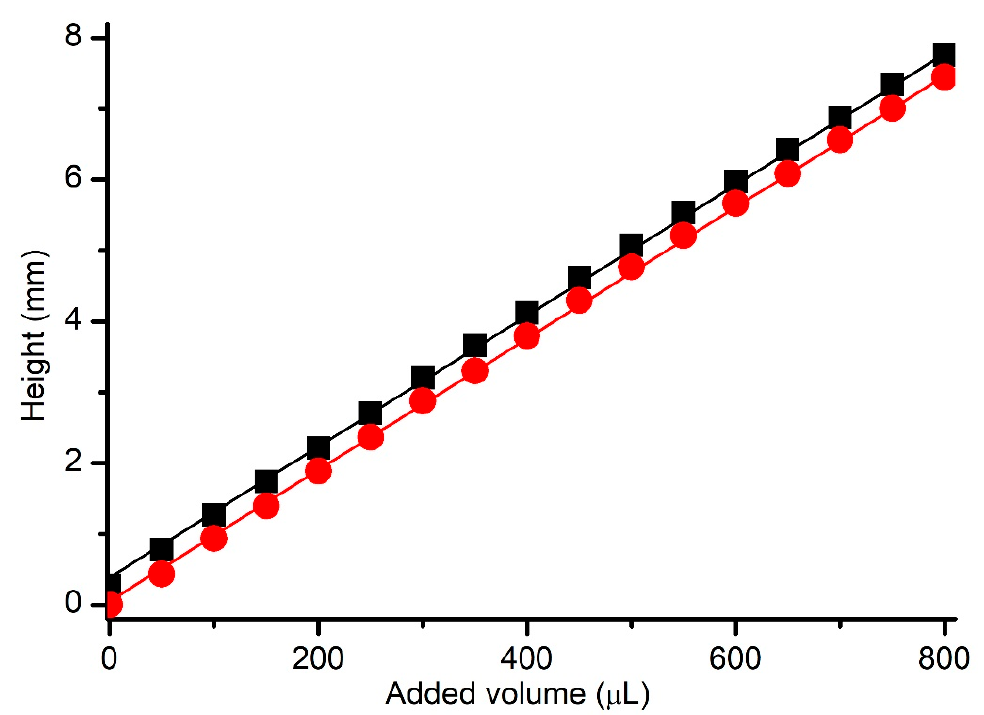
Figure 3. Determination of the relationship between the height of the solution column and added volume. The height measurements were performed by inserting the tip into solutions (red symbols) or retracting it (black symbols). The straight lines represent the linear fit of the experimental data for the two situations. The symbols represent averaged points from triplicate experiments performed on four reservoirs; the standard deviations are smaller than the size of the symbols.